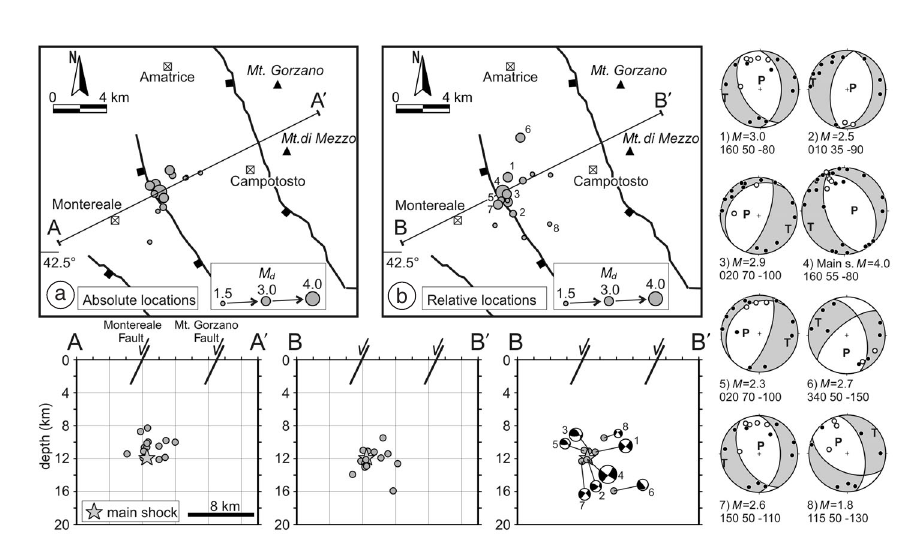
Fig. 3a,b. Absolute (a) and relative (b) locations of the October 1996 seismic sequence (hypocentral parame- ters in tables I and II); hypocentral sections, and focal mechanisms of the events having at least 10 P -wave first motion observations. For each focal mechanism, the magnitude and the attitude of one nodal plane (strike, dip and rake according to the right-hand rule) are indicated.